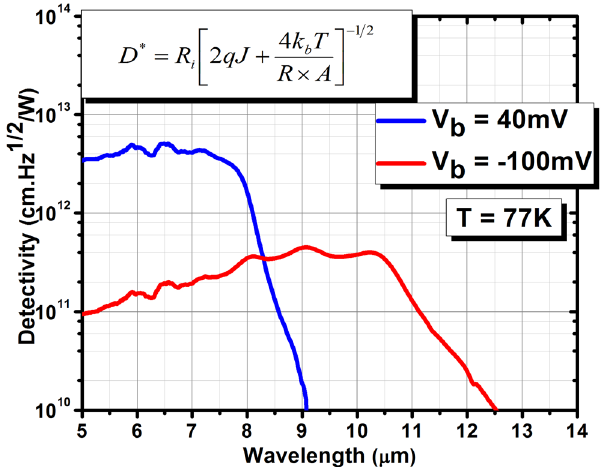
Figure 6. Saturated shot noise–limited specific detectivity spectrum of the blue and red channels at + 40 and − 100 mV applied bias voltage (V b ), respectively, in front-side illumination configuration without any anti- reflection coating. This specific detectivity is calculated using the equation in the inset, where R i is the device responsivity, J is the dark current density, R × A is the differential resistance × area product, k b is the Boltzmann constant, and T is the operating